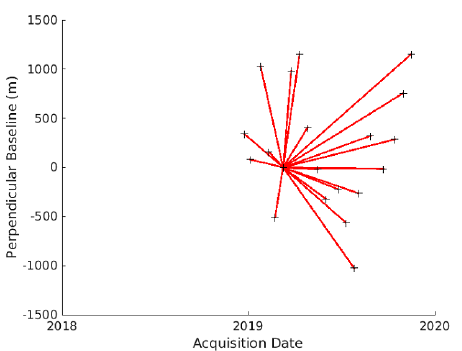
Figure 6. Perpendicular base lines of processed